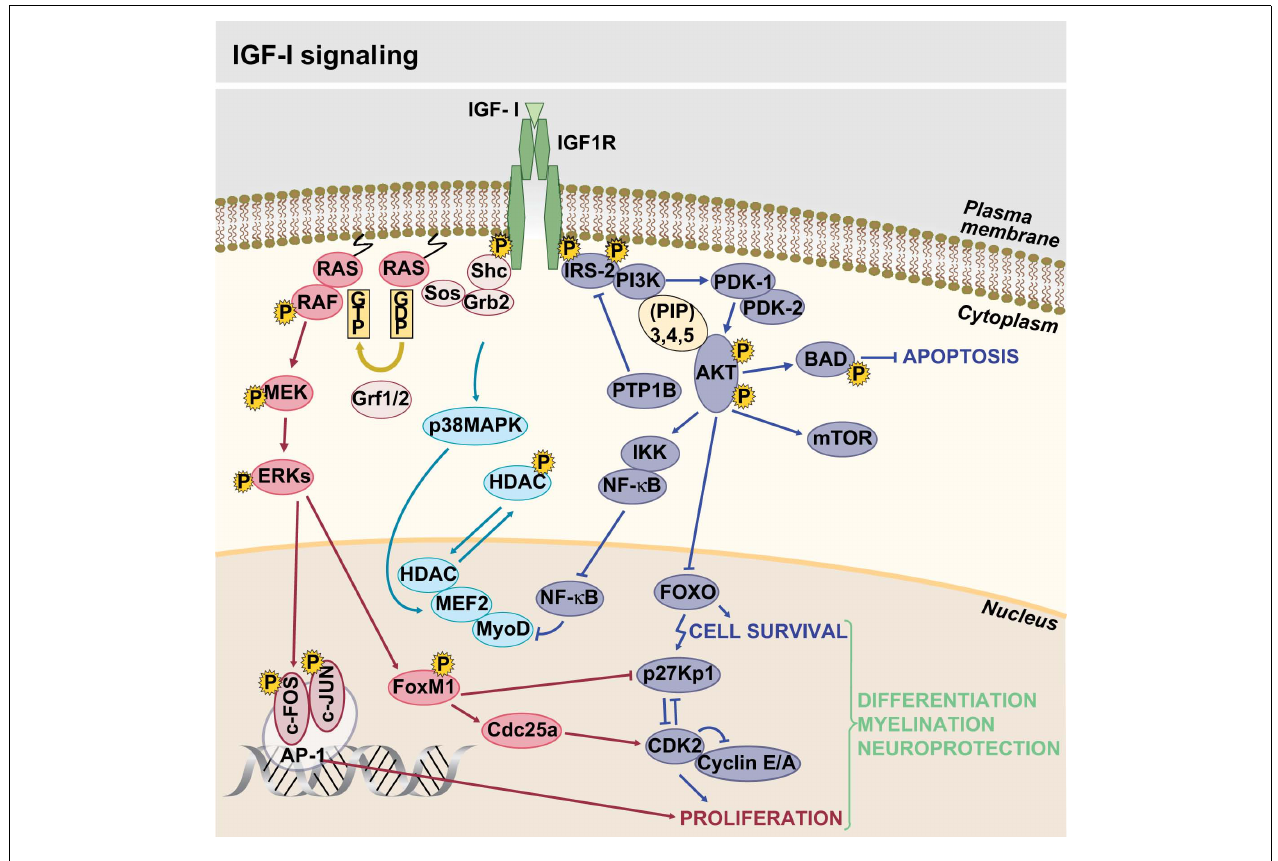
FIGURE 2 | Insulin-like growth factor-I signaling.